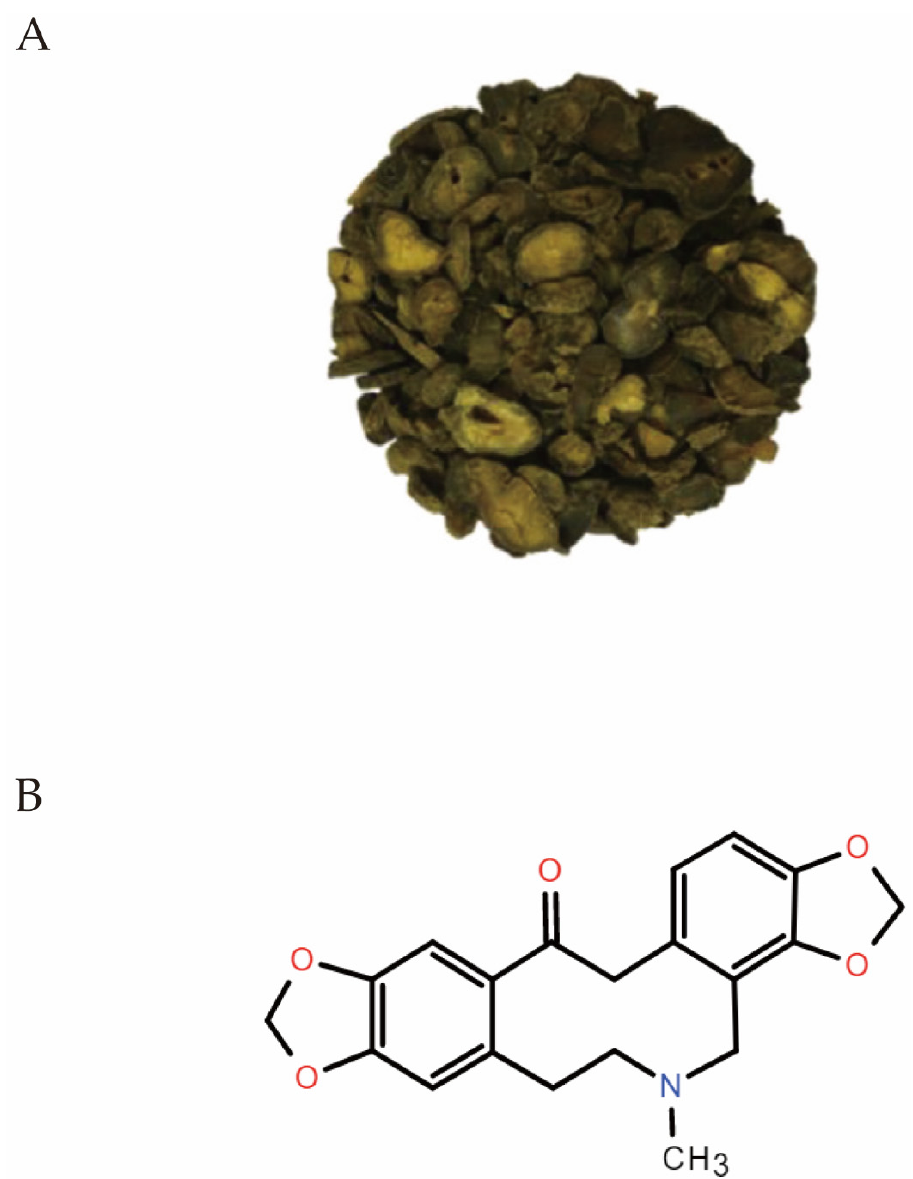
Figure 1. ( A ) A classic picture (reprinted from Elsevier, 131, Alam, M.B., et al., Protopine attenuates inflammation stimulated by carrageenan and LPS via the MAPK/NF-kappaB pathway , Pages 2, Copyright (2019), with permission from Elsevier) of Corydalis yanhusuo W.T. Wang tuber [3]. ( B ) Chemical structure of Protopine.